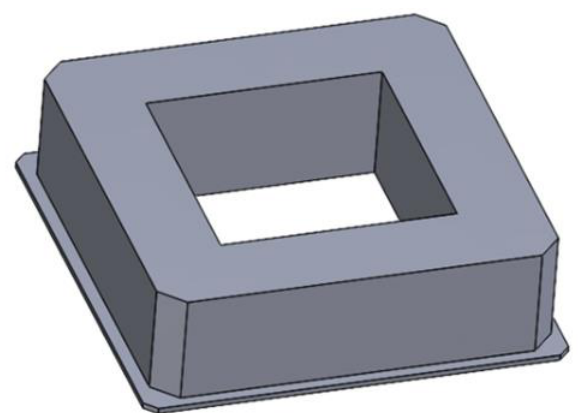
Figure 2. A barge-type platform.